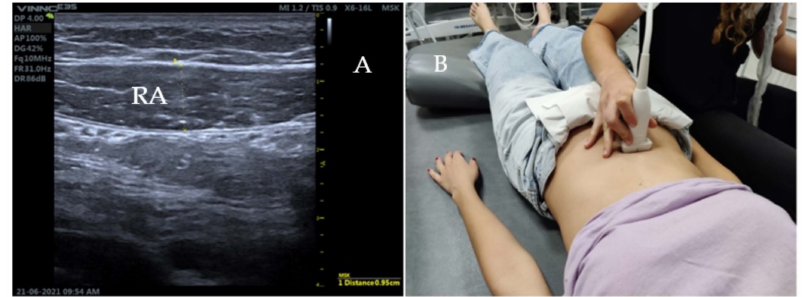
Figure 4. Ultrasound imaging and ultrasonography of the RA. ( A ) represents the RA muscle thickness at rest. ( B ) corresponds to the transducer position above the navel and right by the linea